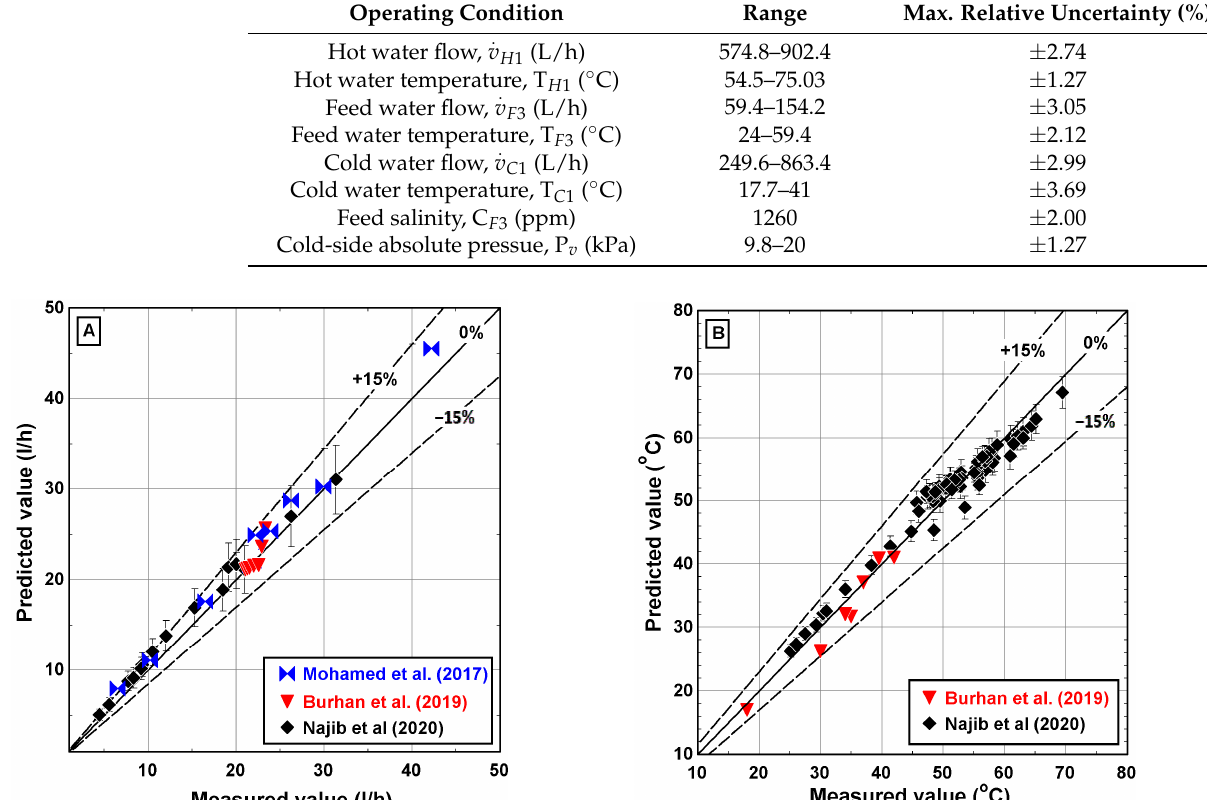
Table 3. Operating conditions.